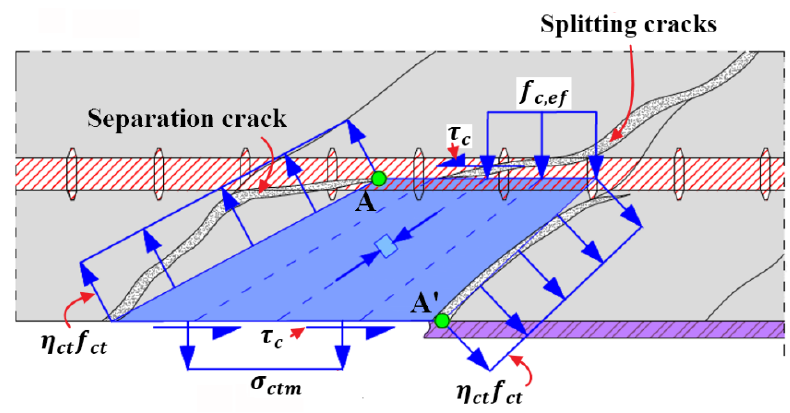
Figure 7. Schematical stress field for cracked concrete block at the end of FRP reinforcement.